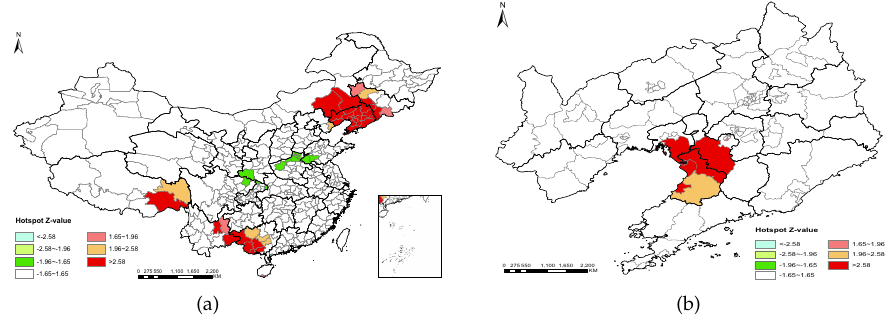
Figure 5. From 1 August 2018 to 31 August 2019: ( a ) Hot spot maps for the incidence of ASF at the city level in Mainland China. ( b ) Hot spot maps for the incidence of ASF at the district or county level in Liaoning